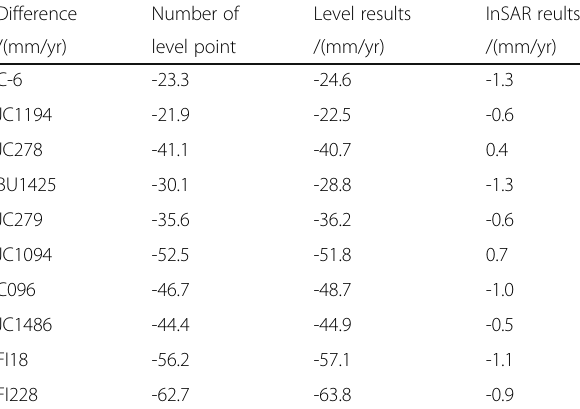
Table 2 Comparison of subsidence rate between InSAR data and level data. Table 2 shows that the error between InSAR data and level data is less than 2 mm, which suggests that